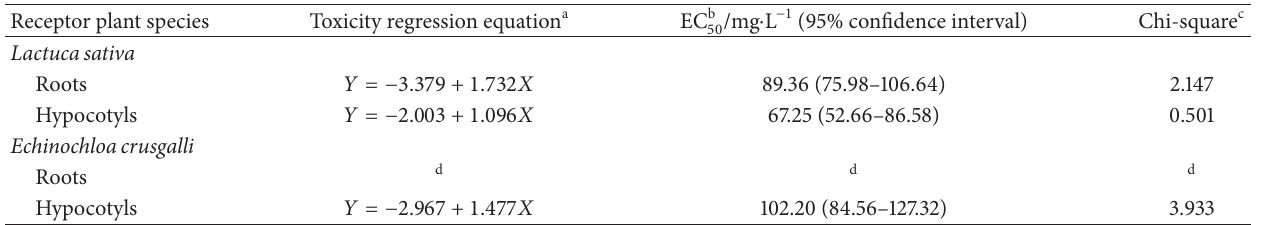
Table 3: Inhibition of 5-fluoro-2-hydroxy butyrophenone on the seedlings growth of two